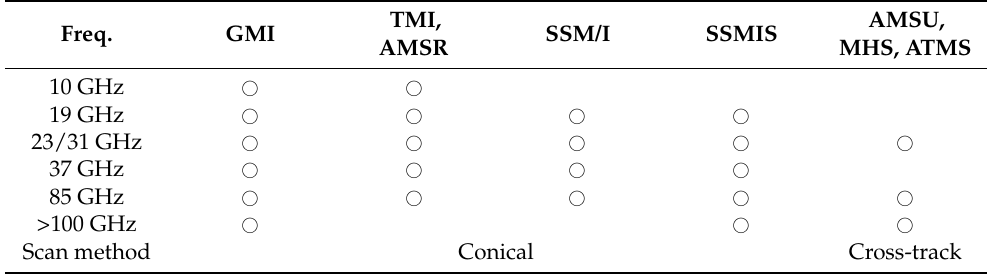
Table 1. Specifications of PMW